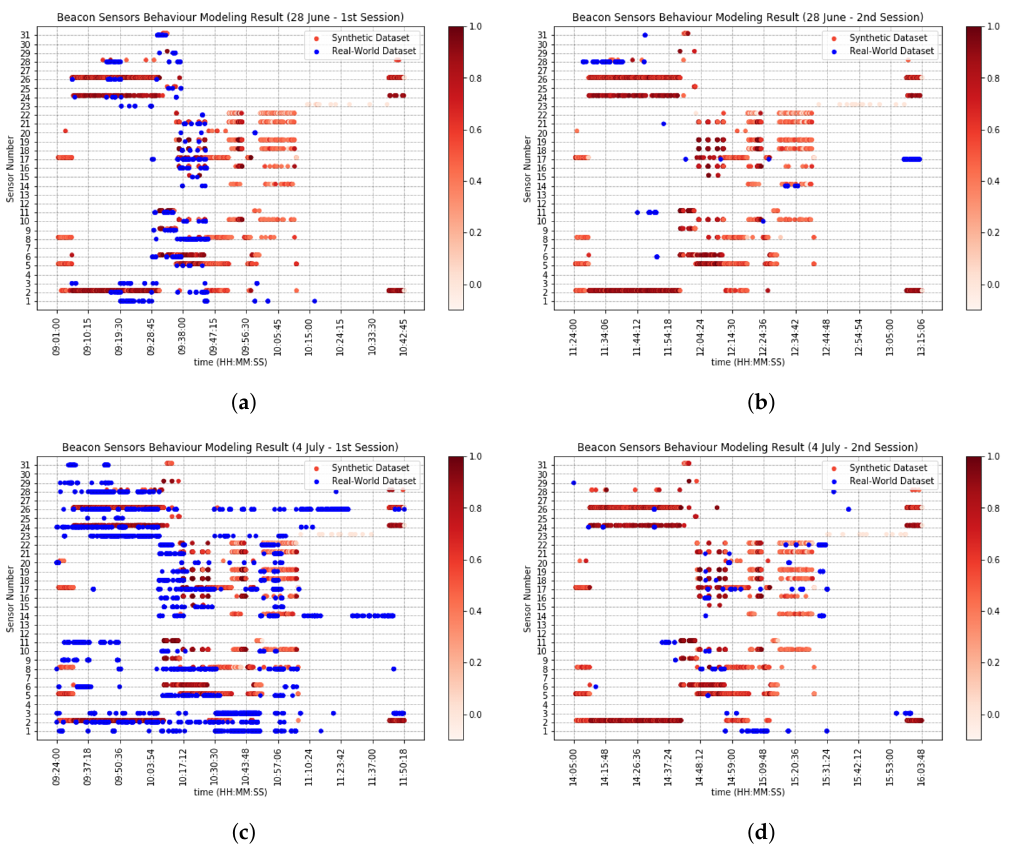
Figure 7. Ground-truth sensor events (blue dots) versus synthetic events (red dots) for for beacons only. Red dots are plotted slightly higher that the line of the particular sensor to avoid